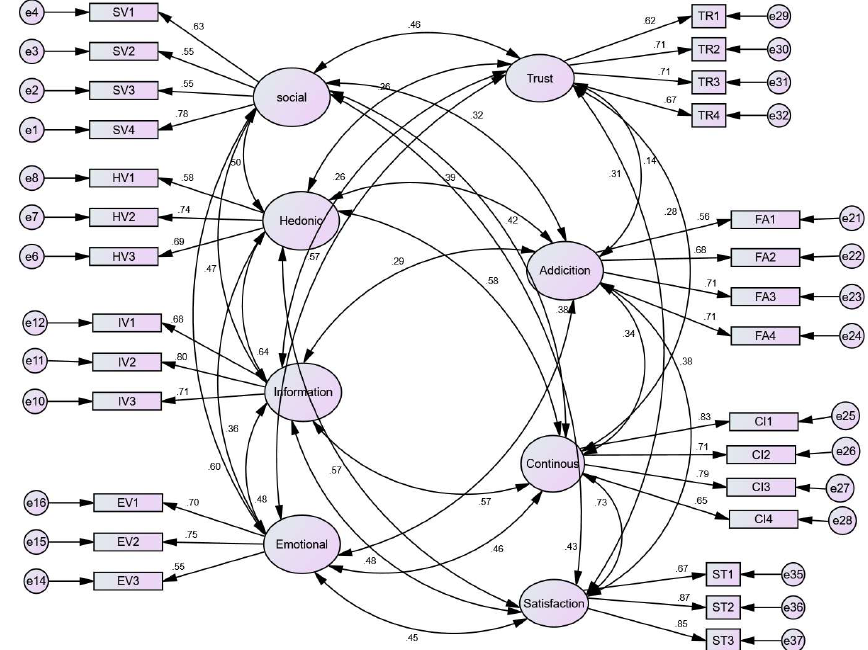
Figure 2. The CFA for the research model.